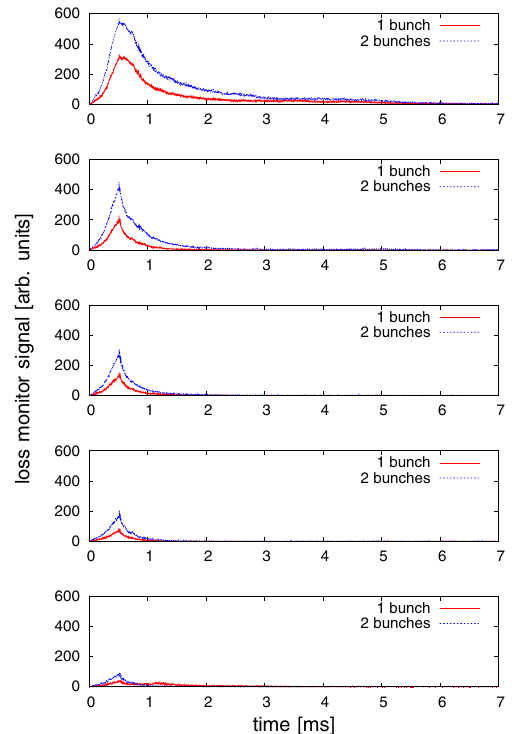
FIG. 9. Comparisons of the beam loss monitor signals near the primary collimator in cases of acceleration of a single bunch and two bunches with various beam intensities. The beam intensities are 2 . 3 × 10 13 ppb, 1 . 7 × 10 13 ppb, 1 . 3 × 10 13 ppb, 0 . 86 × 10 13 ppb, and 0 . 43 × 10 13 ppb, from top to